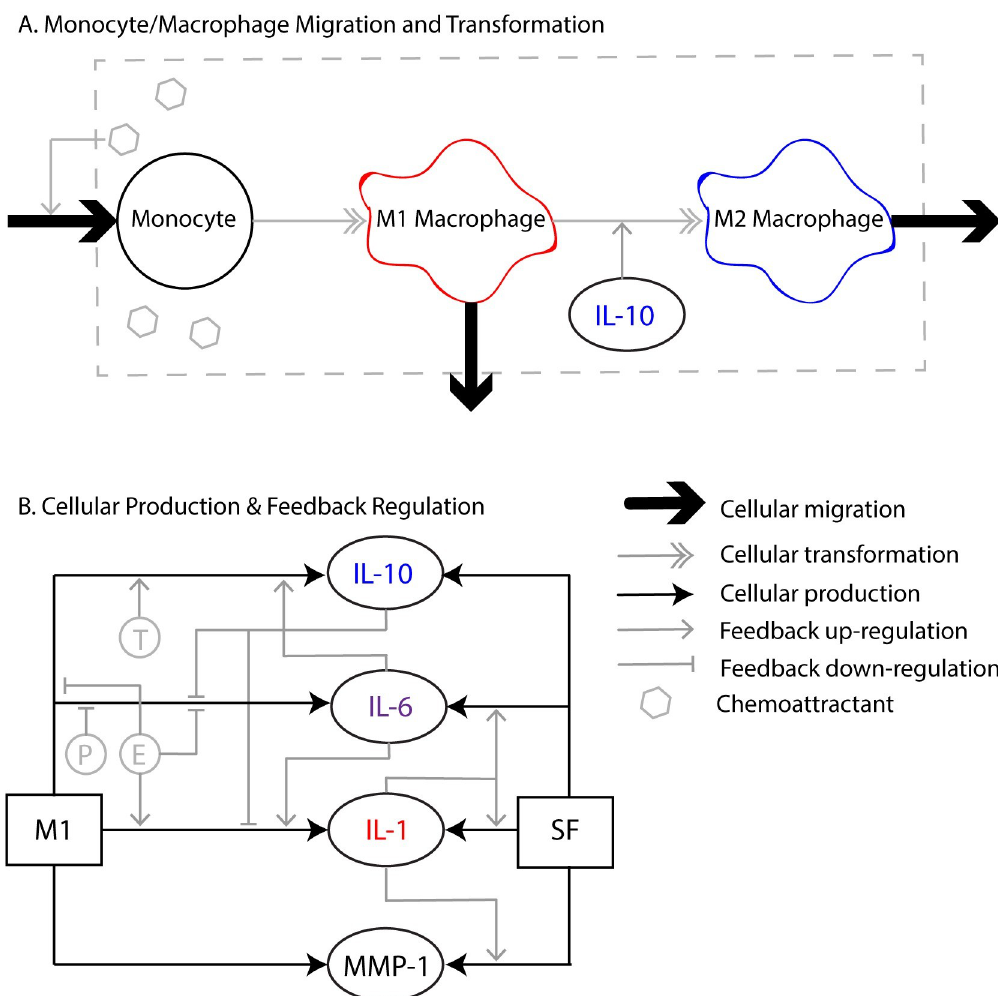
Fig 1. A. Depiction of monocyte and macrophage migration and transformation. Injury to the knee causes the production of chemoattractants, such as TNF- α and TGF- β , which lead to monocyte migration from the bloodstream to the synovium. The synovium is indicated by the gray dashed box. Monocytes transform into pro-inflammatory M1 macrophages. The molecular processes that drive transformation to M1 cells are not modeled. Instead, a 12-hour delay is incorporated into the model as a way to account for the time it takes for monocytes to transform, as previously described [19]. IL-10 drives the transformation of M1 cells to anti-inflammatory M2 macrophages [21]. Both M1 and M2 cells can migrate out of the synovium. B. Cellular production and feedback regulation of a subset of the substances incorporated in the model. M1 and SF both produce IL-10, IL-1, IL-6, and MMP-1. IL-10 down-regulates M1 production of IL-1 and IL-6, while IL-1 up- regulates SF production of IL-1, IL-6, and MMP-1. IL-6 up-regulates M1 IL-10 and up-regulates M1 IL-1. Estrogen (E) up- regulates M1 production of IL-1 and down-regulates M1 production of IL-10 and IL-6, while testosterone (T) up-regulates M1 production of IL-10. Progesterone (P) down-regulates M1 IL-6. M1: pro-inflammatory macrophage. M2: anti- inflammatory macrophage. SF: synovial fibroblast. E: estrogen. T: testosterone.